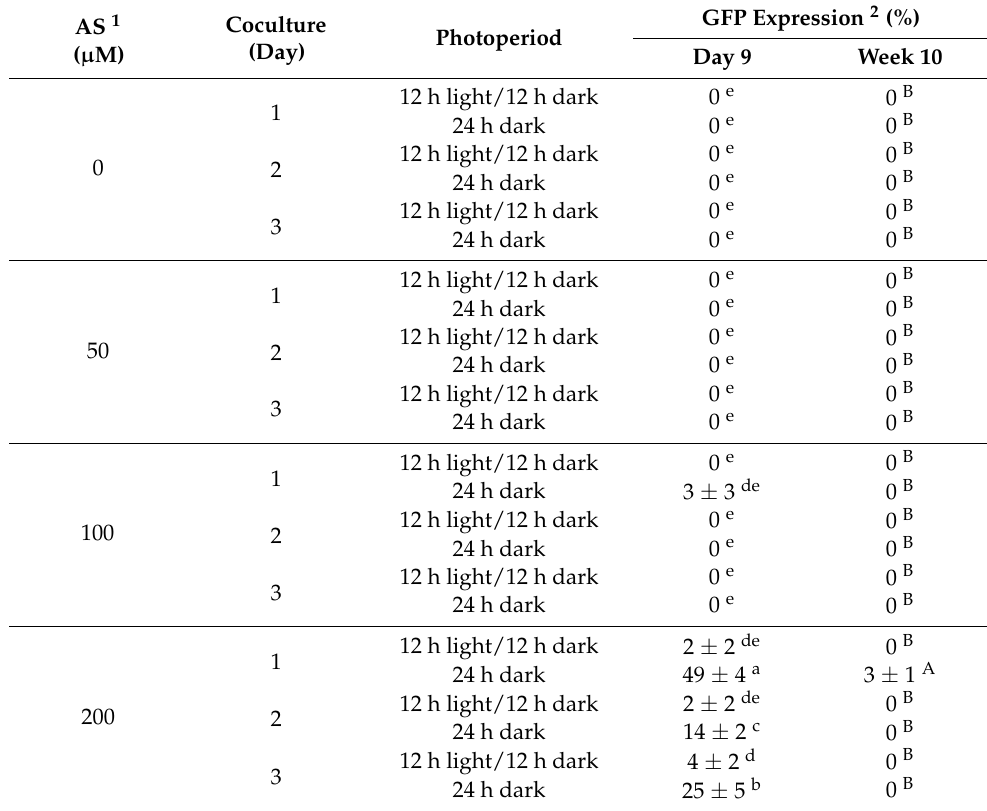
Table 3. The effects of different transformation parameters on GFP expression in nodular calli of